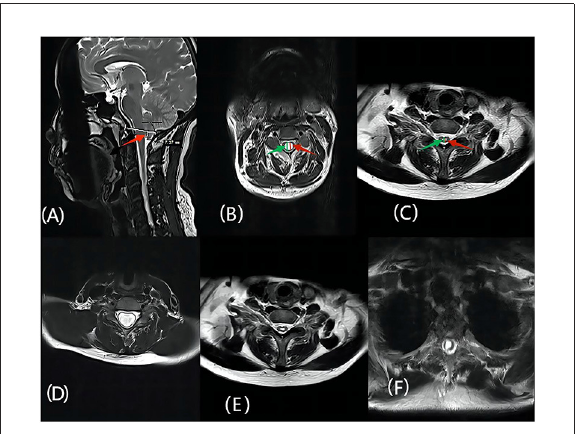
FIGURE1 (A) The red arrow represents the herniated cerebellar tonsil; (B) The green arrow represents the diameter of the patient’s spinal cord before surgery, defined as b, the red arrow represents the maximum anteroposterior diameter of the preoperative syrinx, which is defined as a; (C) The red arrow represents the maximum anteroposterior diameter of the postoperative syrinx, defined as a1, the green arrow indicates the maximum diameter of the spinal cord after surgery, defined as b1; (D–F) represent the morphological features of the syringomyelia, which are enlarged, central, and deviated, respectively.